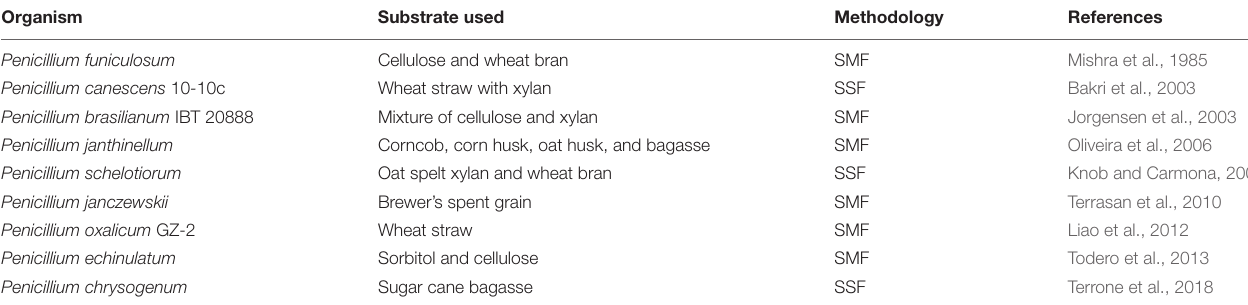
TABLE 1 | Xylanase production by different Penicillium species from previous